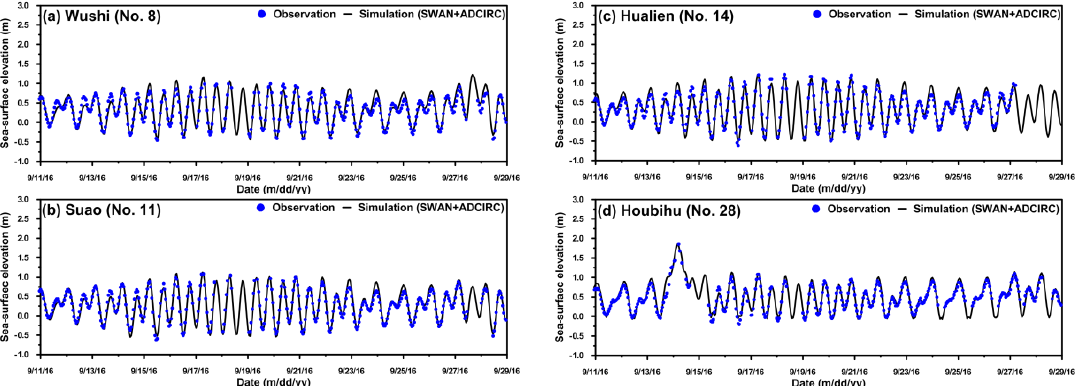
Figure 7. Model-data comparison for the sea-surface elevation at the ( a ) Wushi (No. 8), ( b ) Suao (No. 11), ( c ) Hualien (No. 14) and (d) Houbihu (No. 28) tide-measuring stations during Typhoons Meranti (Sep. 12–15), Malakas (Sep. 15–18) and Megi (Sep. 25–28) in 2016( d ).